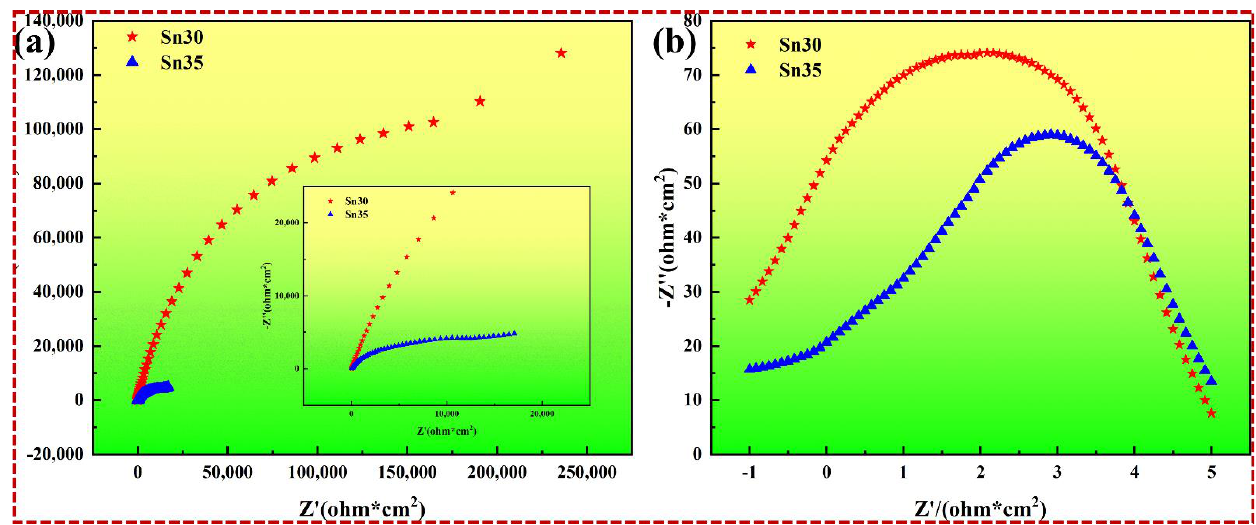
Figure 9. EIS of Sn30 BHEA and Sn35 BHEA: ( a ) Nyquist plots, ( b ) Bode plots.